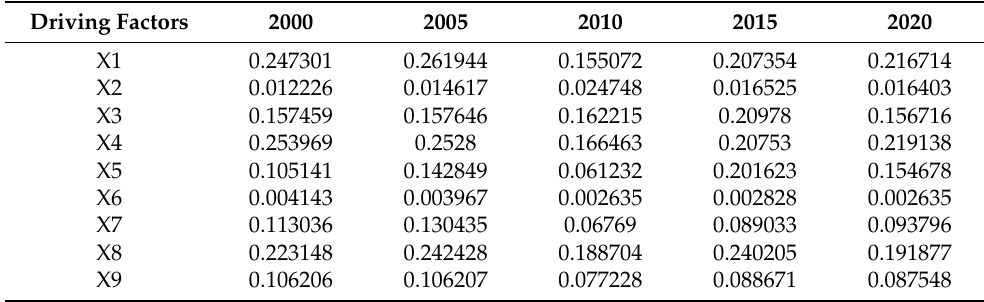
Table 7. Detection results of driving factors for spatial differentiation of ESVs in Sichuan